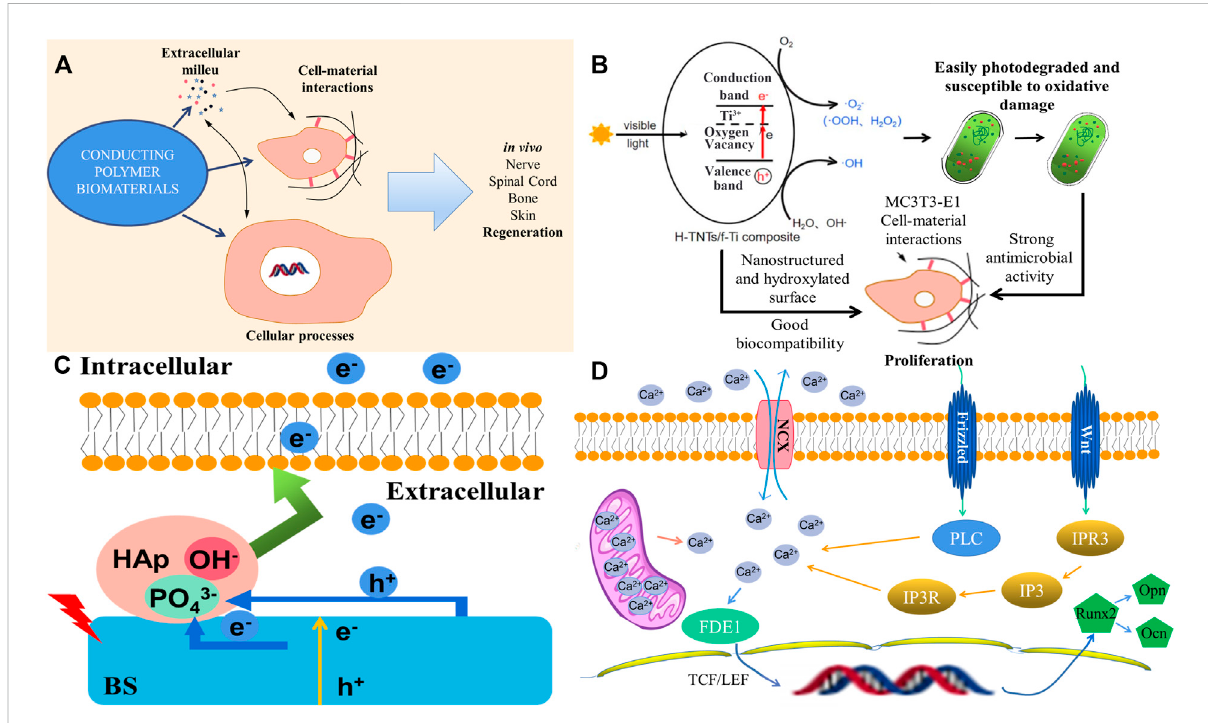
FIGURE 4 The mechanism and effect of photoelectric-responsive materials. (A) Conducting polymers and their effects on the tissue environment, cell outcomes, and in vivo regeneration. (B) Diagram of the interaction between photoelectrons and cells. (C) Diagram of the Ti-BS/HAp